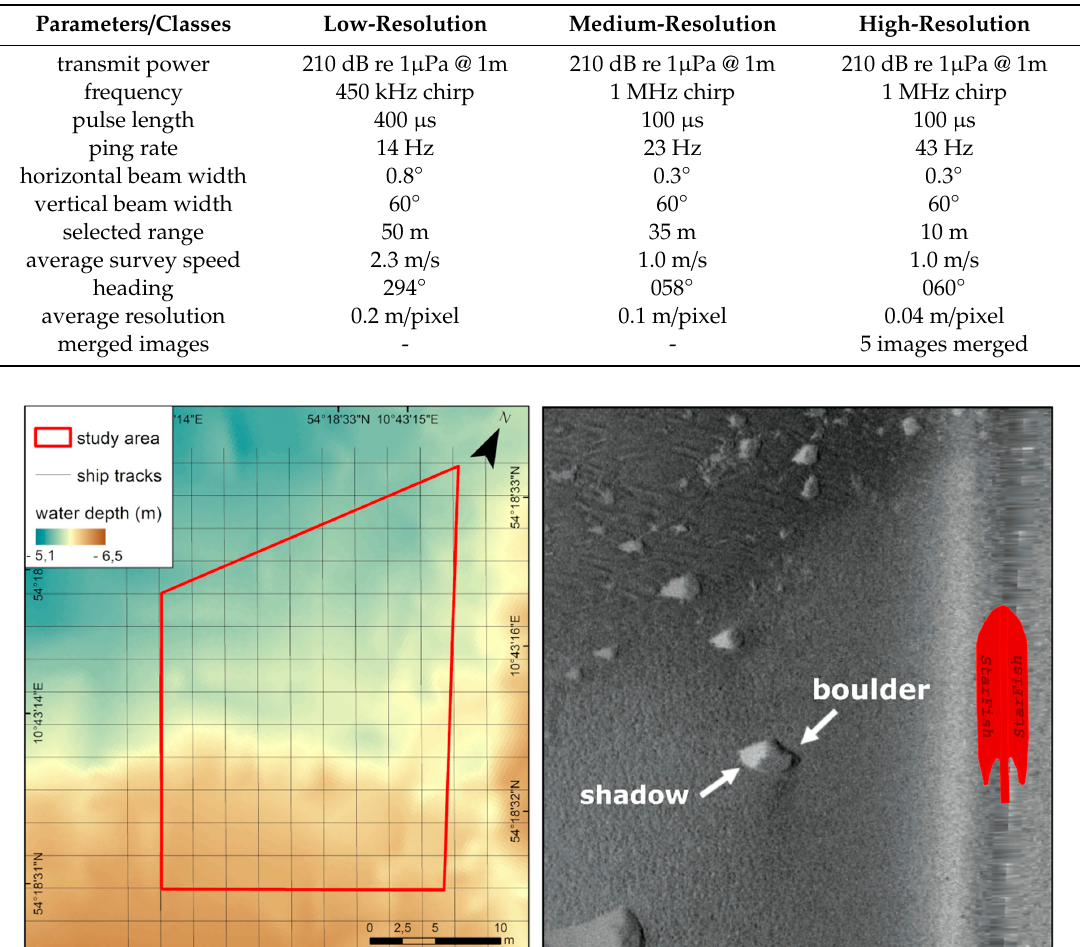
Table 1. Three sidescan sonar (SSS) resolution classes; acoustic parameters of the sidescan transducer and selected survey parameters.